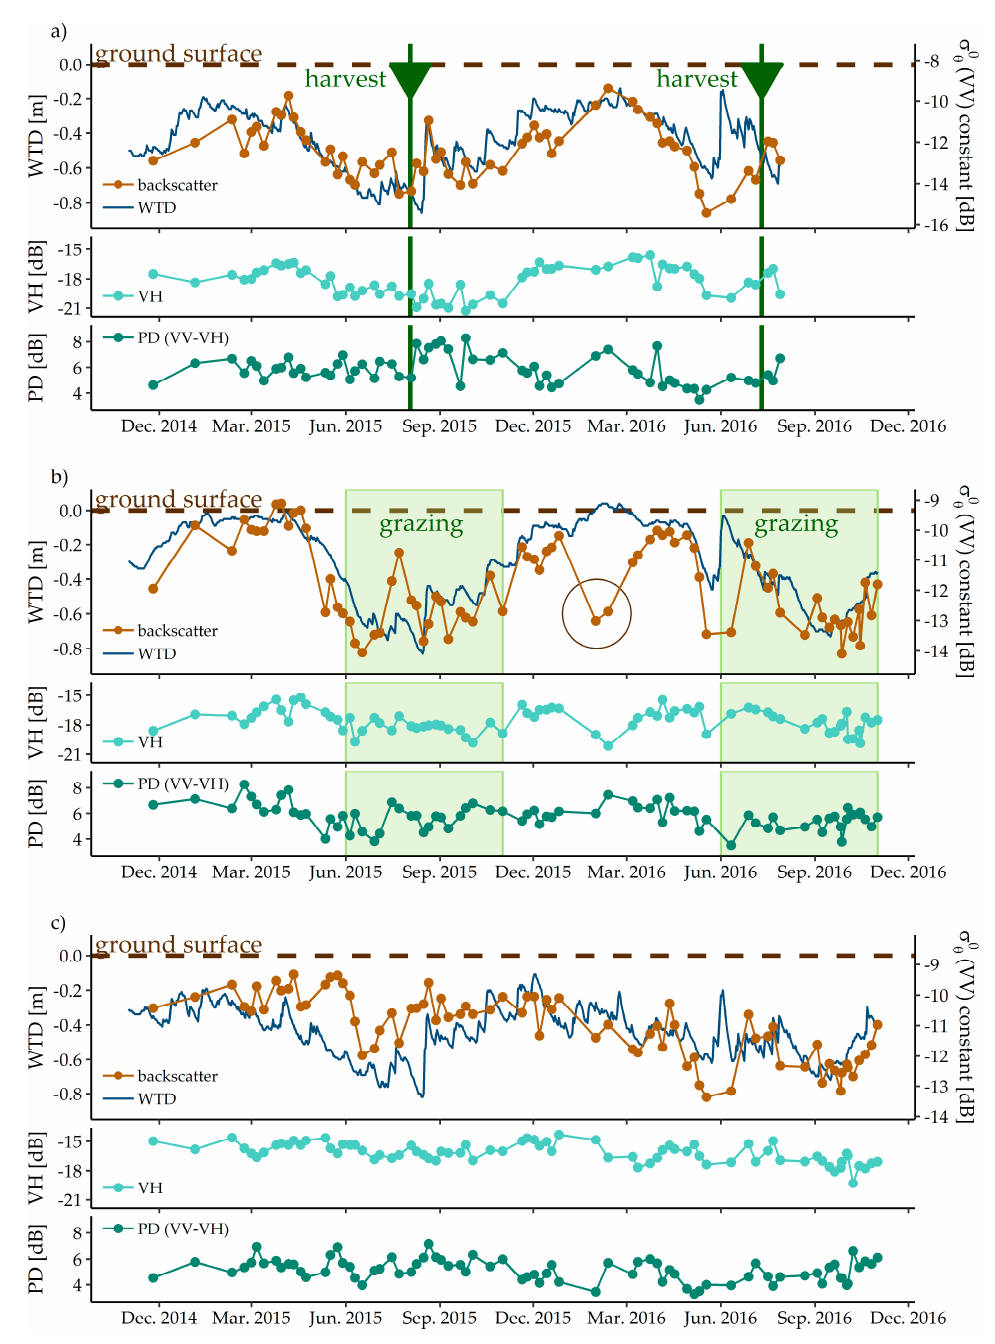
Figure 8. Time series of water table depth (WTD), backscatter coe ffi cients ( σ 0 θ (VV) constant and σ 0 θ (VH) constant, ascending), and polarization di ff erence (PD) for three di ff erent exemplary study sites (Figure 3). The first study site ( a ) Meadow is cut once a year in August, which is marked with arrows (r = 0.75). At the second study site ( b ) Pasture one major inundation event occurred, marked with a circle, and the grazing period is highlighted in green (r = 0.77). The third site, ( c ) Grazing meadow is an example of a low correlation coe ffi cient (r = 0.37).